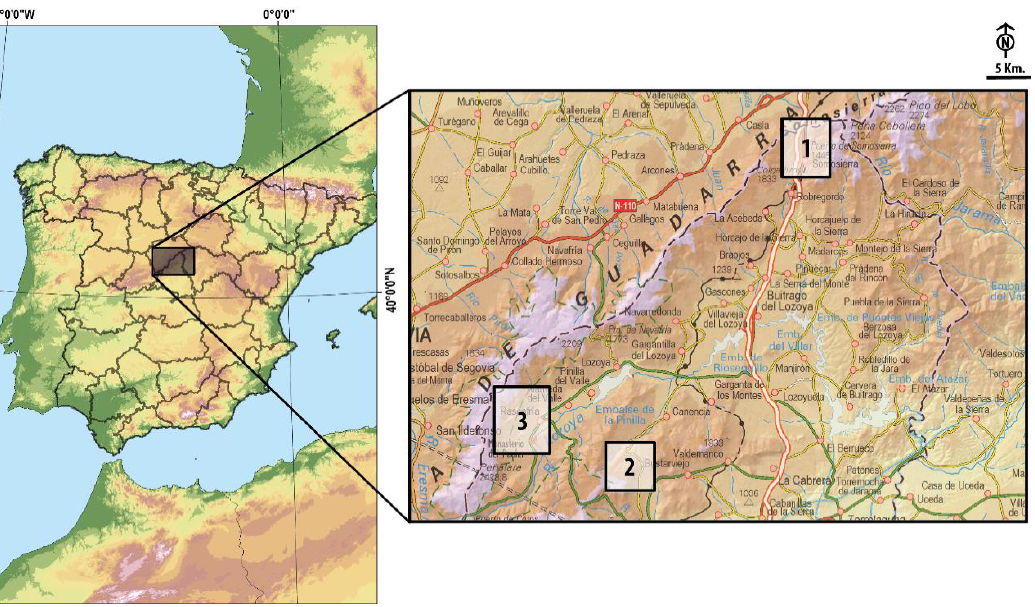
Figure 1. Study area (1. Somosierra; 2. Bustarviejo—Arroyo del Valle; 3. Rascafría). Map base source: Spain MDE from USGS Shuttle Radar Topography, 2004 [28]. Topographic information from the National Geographic Institute 1:200,000 [29].